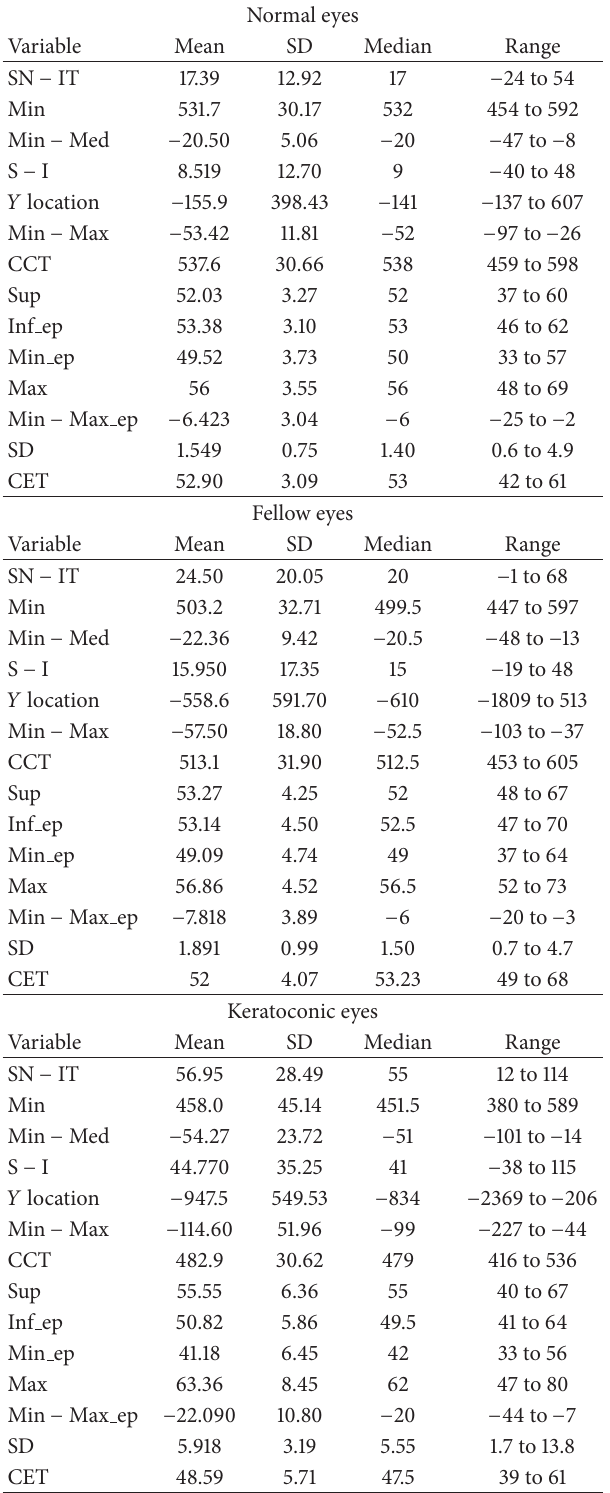
Table 1: Data obtained for the three groups of eyes.